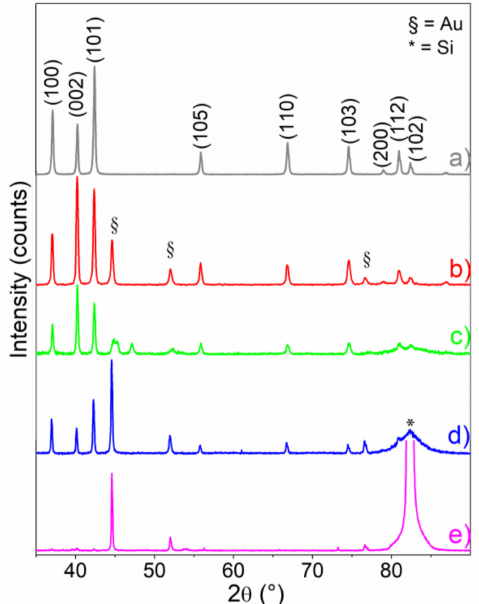
Figure 1. XRD patterns of: Kadox ZnO ( a ) and ZnO spherical microcages grown at 700 ◦ C for 3 h ( b ), at 700 ◦ C for 22 h ( c ), at 800 ◦ C for 3 h ( d ) and at 900 ◦ C for 3 h ( e ) obtained on Au thin film. XRD diffraction planes of Zincite (PDF card No. #00-036-1451) are also